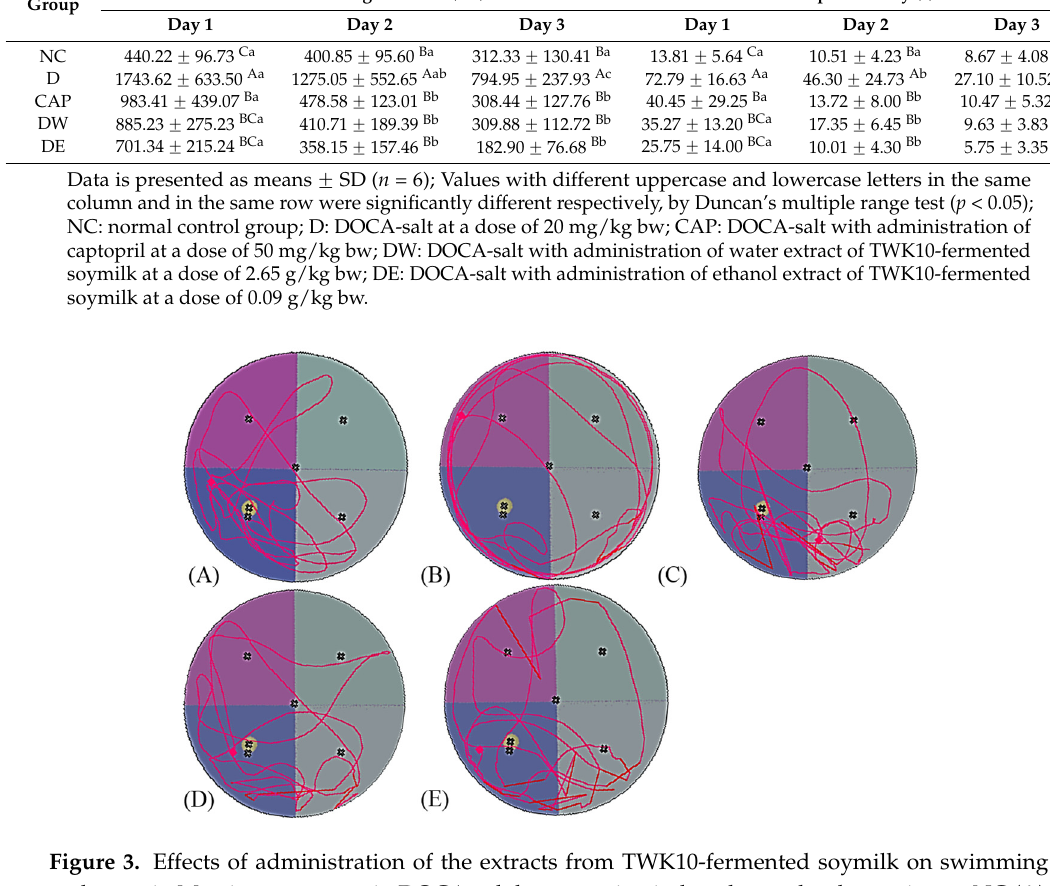
Figure 3. Effects of administration of the extracts from TWK10-fermented soymilk on swimming pathways in Morris water maze in DOCA-salt hypertension induced vascular dementia rats NC ( A ); D ( B ); CAP ( C ); DW ( D ); and DE ( E ). NC: normal control group; D: DOCA-salt at a dose of 20 mg/kg bw; CAP: DOCA-salt with administration of captopril at a dose of 50 mg/kg bw; DW: DOCA-salt with administration of water extract of TWK10-fermented soymilk at a dose of 2.65 g/kg bw; DE: DOCA-salt with administration of ethanol extract of TWK10-fermented soymilk at a dose of 0.09 g/kg bw. Table 4. Effects of administration of the extracts from TWK10 ‐ fermented soymilk on the probe test in Morris water maze in DOCA ‐ salt induced hypertension and its associated dementia rats.